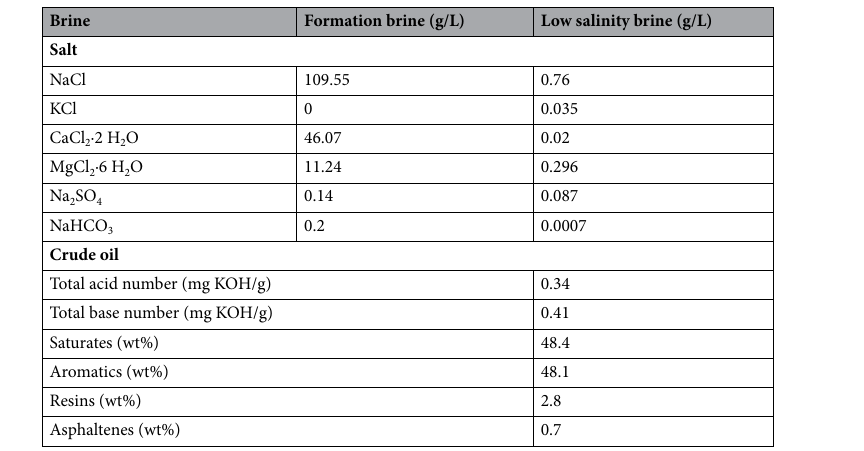
Table 1. Composition and properties of the fluids used in this